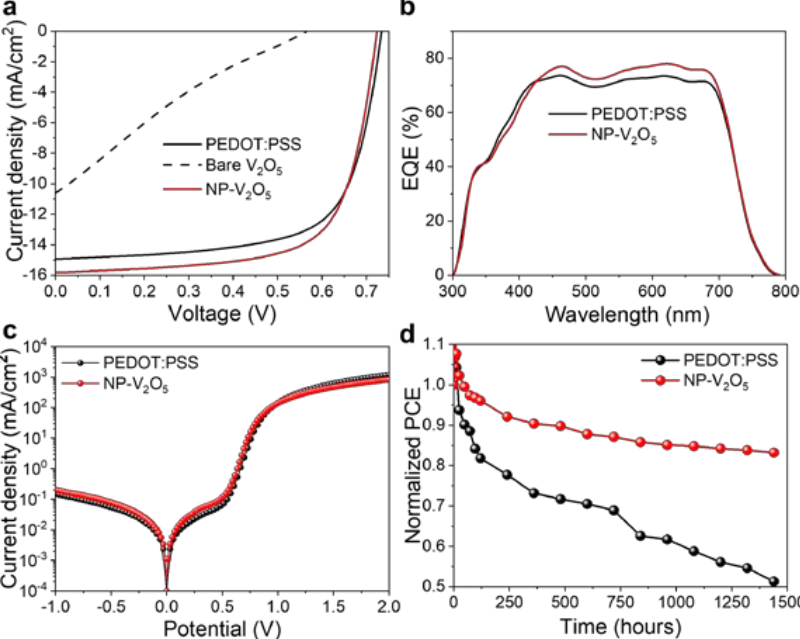
Figure 3. ( a ) Photocurrent density–voltage curves; ( b ) external quantum e ffi ciency (EQE) curves; ( c ) logarithmic current density–voltage curves characterized under a dark condition; ( d ) normalized PCE values as a function of storage time for the OSCs. Here, PEDOT:PSS is poly(3,4-ethylenedioxythiophene):